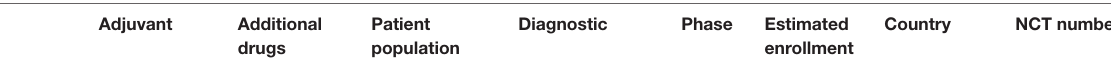
TABLe 1 | Currently ongoing peptide and tumor vaccine trials in tumors located in the